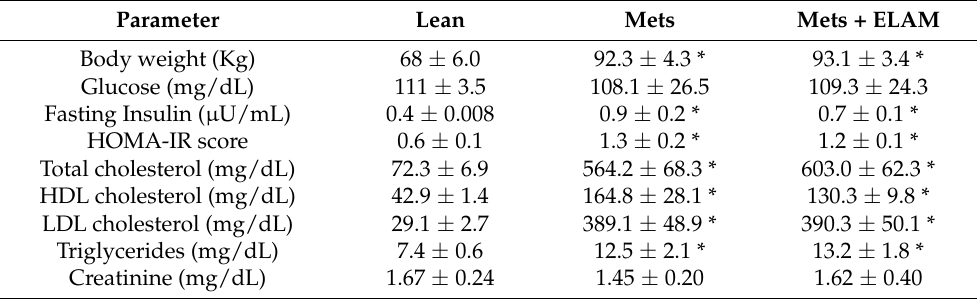
Table 1. Systematic parameters in pigs with a 16-week metabolic syndrome (MetS) untreated or treated with elamipretide